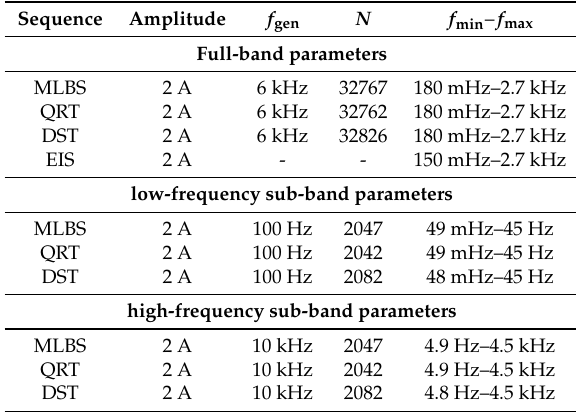
Table 1. Design parameters for the